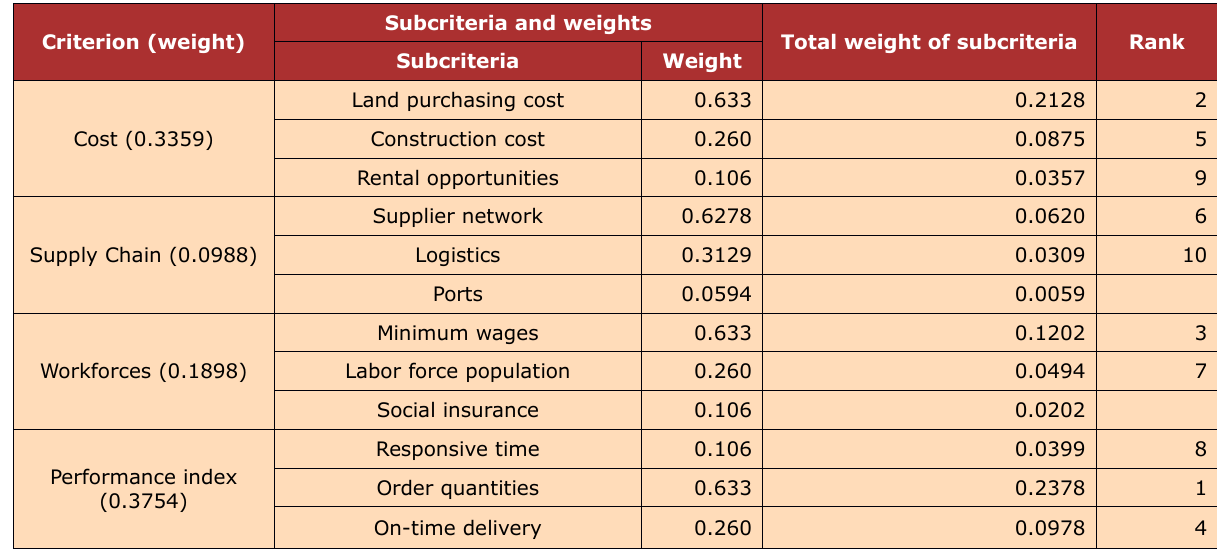
Table 10. Ranking of the subcriteria for four